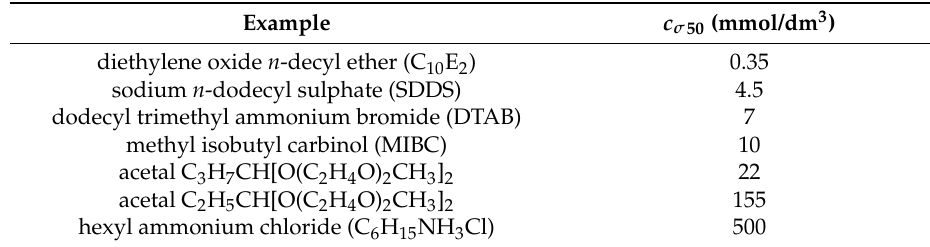
Table 10. c σ 50 values of selected surfactant frothers.